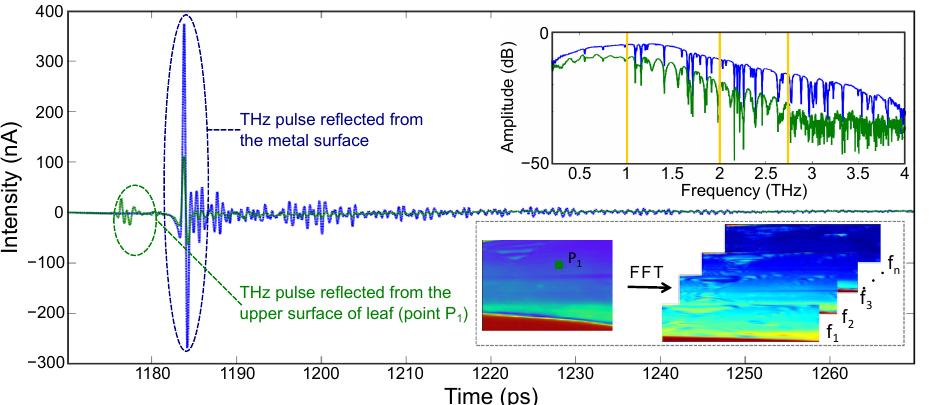
Figure 4. Schematic showing the post-processing of experimental data: typical experimentally obtained time-domain signal and images in broadband THz TDS imaging setup and the post- processed amplitude and phase